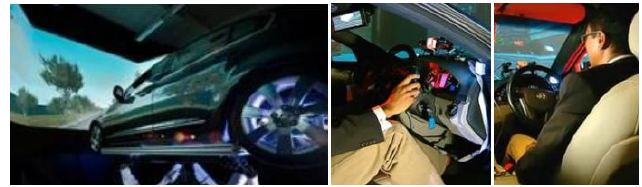
Fig. 4. BCI for car driving in virtual simulator CARRS-Q. Source: [42].